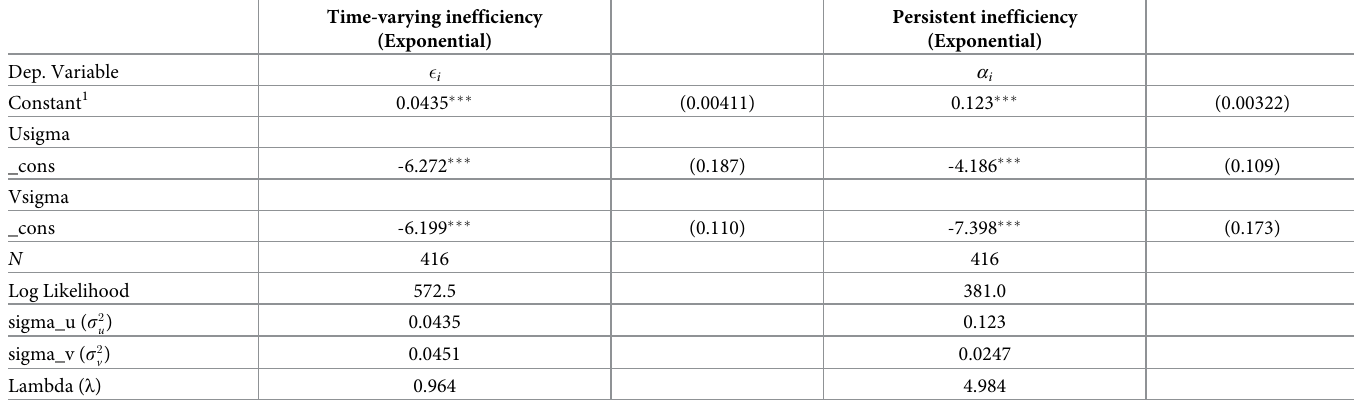
Table 5. The estimation of time-varying and persistent VAT inefficiency by the stochastic tax frontier model for EU-26 countries, 2000–2015. Time-varying inefficiency